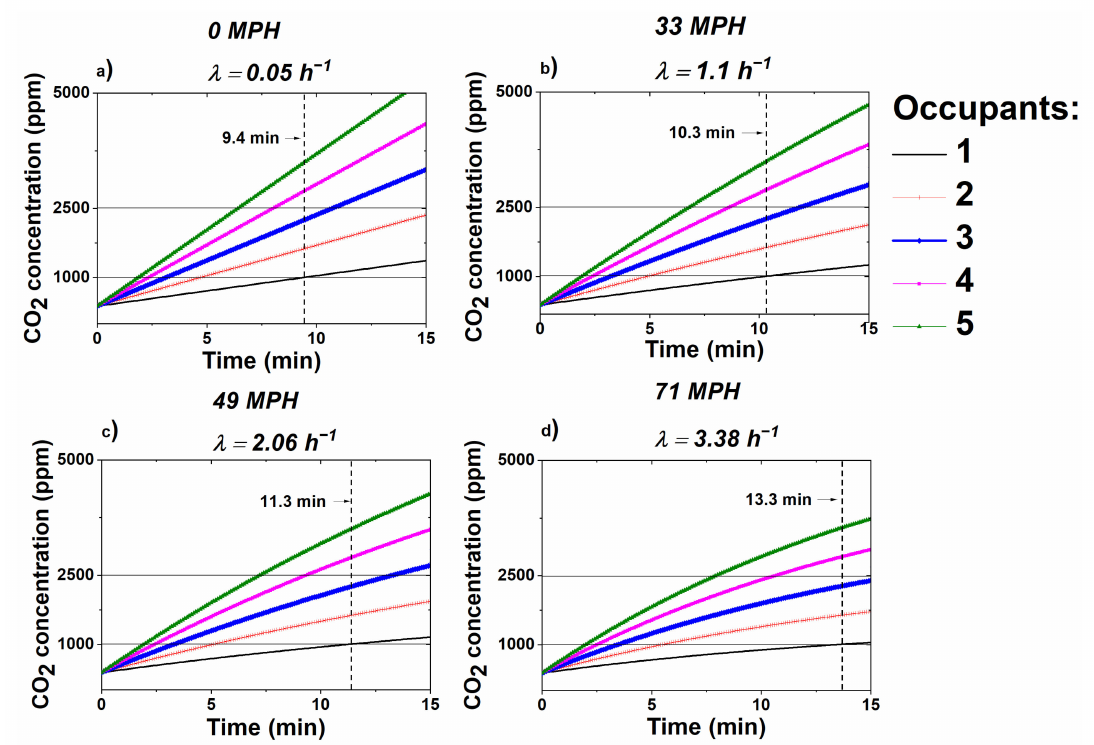
Figure 6. Modeled CO 2 concentration profile for various driving speeds and number of occupants